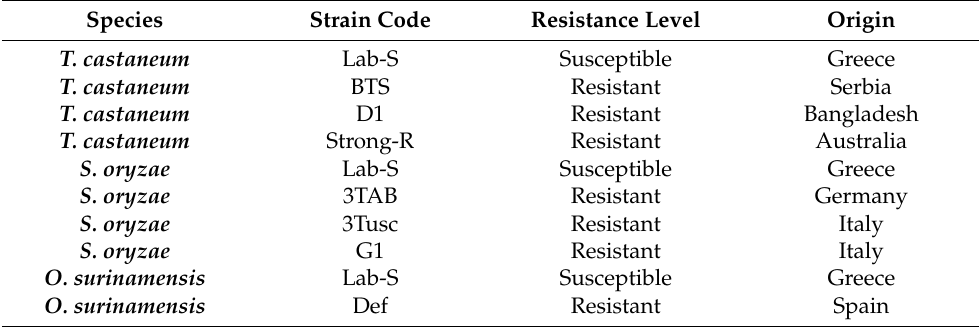
Table 1. Insect species and populations used in the nitrogen trials, their origin, and their phosphine resistance level.